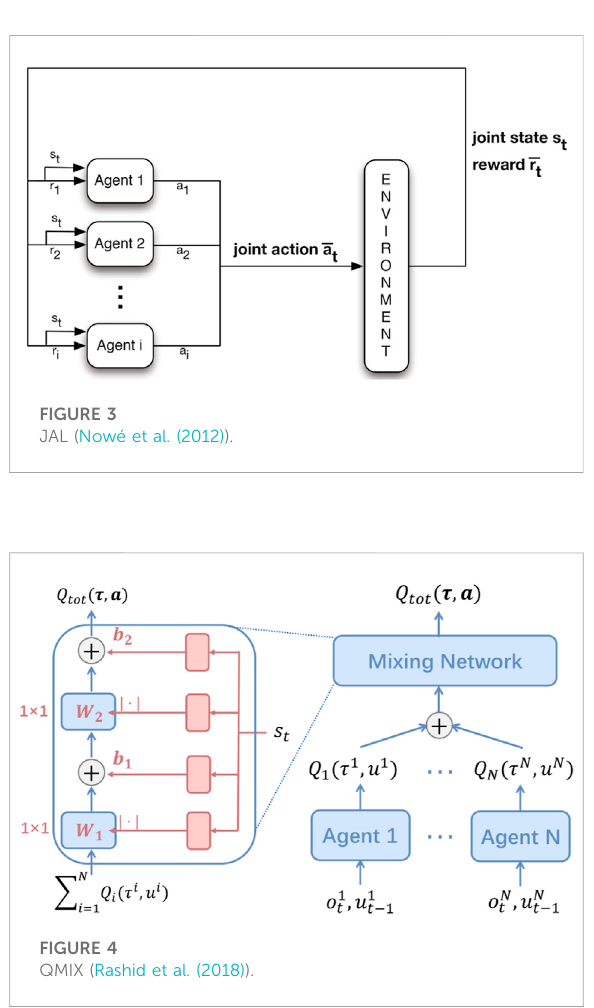
FIGURE 4 QMIX (Rashid et al.